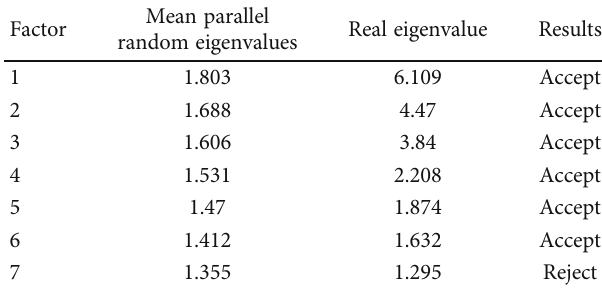
Table 3: Horn ’ s parallel analysis test